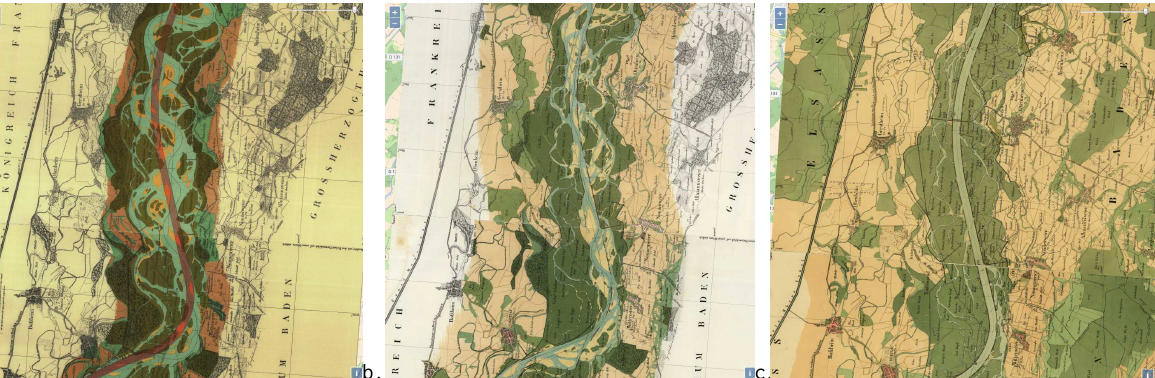
Figure 6. Rhine river in correspondence of Meißenheim: the original riverbed in 1830 (light blue) and the rectification project (red)